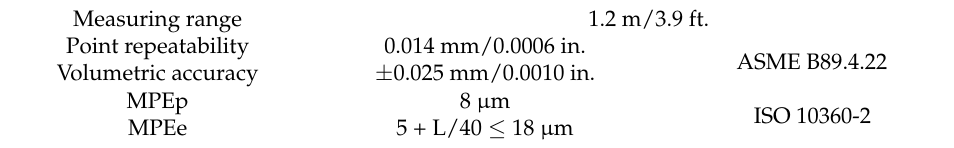
Table 4. RA-7312 measuring arm speci fi cations.